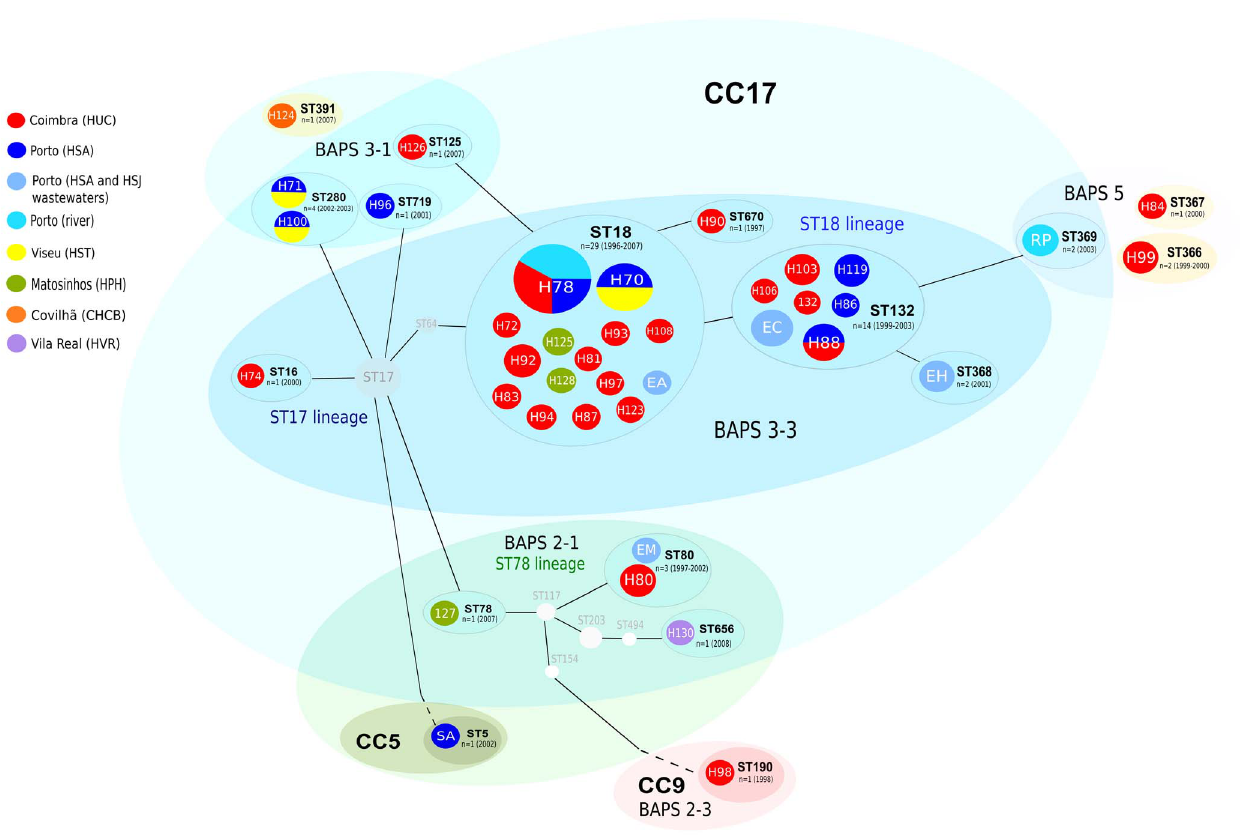
Figure 1. Population of vancomycin resistant Enterococcusfaecium. Abbreviations: ST, sequence types; CC, clonal complex; BAPS, Bayesian Analysis of Population Structure; HUC, Hospital Universita´rio de Coimbra; HSA, Hospital Santo Anto´nio; HSJ, Hospital Sa˜o Joa˜o; HST, Hospital Sa˜o Teoto´nio; HPH, Hospital Pedro Hispano; CHCB, Centro Hospitalar da Cova da Beira; HVR, Hospital S. Pedro. A colored circle represents each PFGE type (white numbers/letters; H for hospital, SW for sewage, R for river and S for swine clones) and each PFGE type is associated with the corresponding sequence type (STs are represented in black letter and in colored elipses grouping different PFGE types) and BAPS group (in colored elipses grouping different STs). The size of the colored circles corresponds to the number of isolates. CC17 (in light blue), CC5 (in light green), CC9 (in light red) and the singletons ST366, ST367 and ST391 (light yellow) are represented according to the eBURST algorithm (download on 26 th January 2012) with black lines joining single locus variants (SLV). STs that were not identified in this study are represented as light grey nodes to link the sequence types identified in this study accordingly to eBURST. ST18 strains (H70, H78, H87, H93, H108, H125) and most ST132 strains (H86, H88, H106, SWC) were clonally related by PFGE ( , 7 bands difference). Remarkable relationships among PFGE banding patterns of strains belonging to different STs were observed (H125/ST18 and H126/ST125; H124/ST391 and H71/ST280, SWM/ST80 and H86/H88/H106/H119/SWC/ST132, and isolates SWA/ST18 and SWC/ST132 ( , 8 bands difference). This figure drawn up was performed in the ‘‘Open Source vector graphics editor Inkscape’’ (version